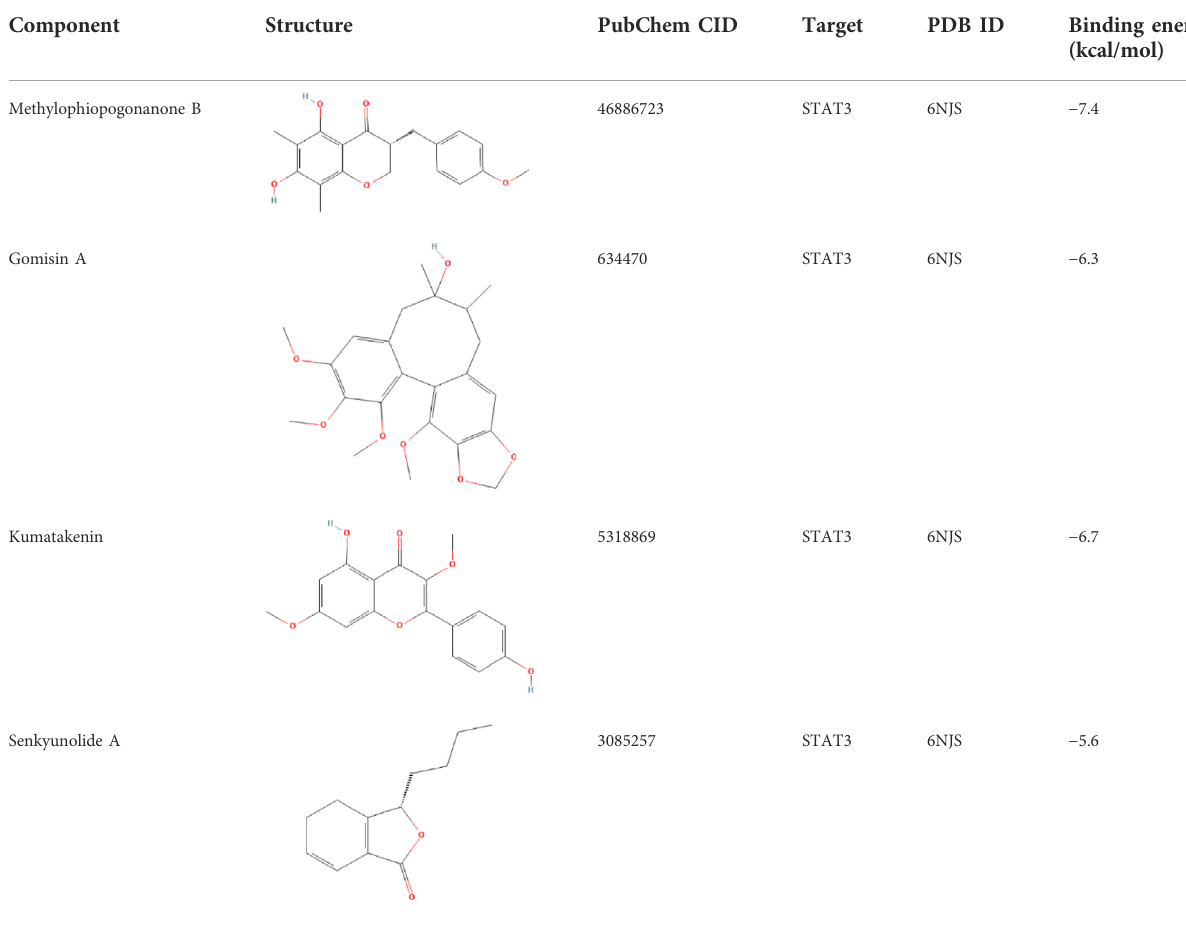
TABLE 4 Details of molecular